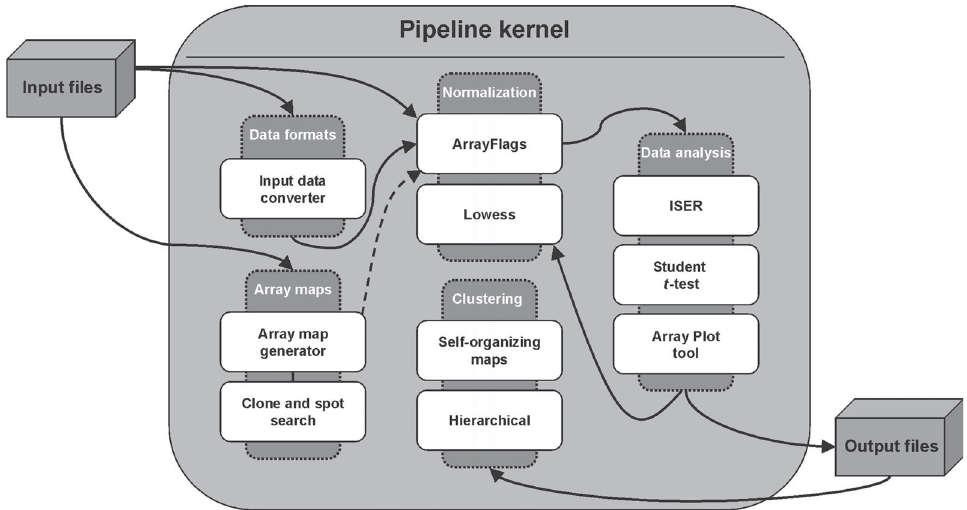
Figure 1. The diagram of the pipeline for macro- and microar- ray analyses. A pipeline kernel diagram of pipeline for macro- and microarray analyses shows the ten modules in five classes (dotted boxes). Solid arrows in- dicate the flow of information and the dashed arrow indicates an optional flow. Note that the output of the analysis may be edited prior to appropriate clus- tering. ISER = intensity-depen- dent selection of expression ra-